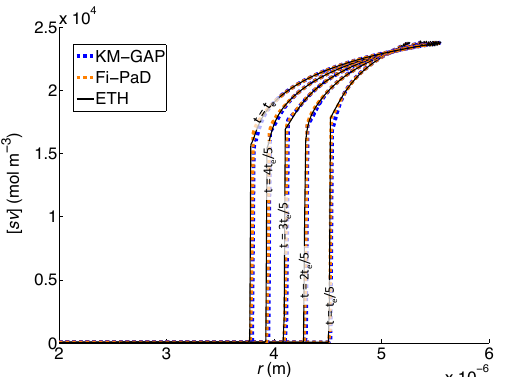
Figure 5. The concentration ([sv])-radius ( r ) profiles of the semi- volatile component at times ( t ) preceding and including the e - folding time ( t e ) as estimated by the three models given in the leg- end, for the case of logarithmic dependence of D i on x sv , an instan- taneous increase in e s from 1 to 90% and with D 0 nv = 1 × 10 − 25 and D 0 sv = 2 × 10 − 9 m 2 s − 1 . Note that for clarity the radius axis begins at 2 × 10 − 6 m and not 0m.